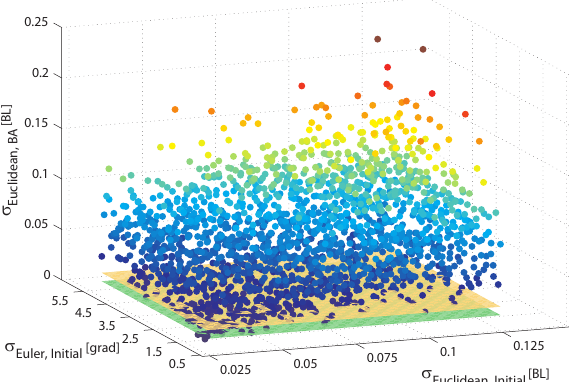
Figure 4: Median of the RMS of the translation parameters after a Monte-Carlo simulation of an incremental robust bundle ad- justment using different combinations of initial value accuracies (dots, coloured with respect to the distance to the ground truth). The planes depict the standard deviation of the translation pa- rameters of our approach (orange) and our approach plus a final bundle adjustment